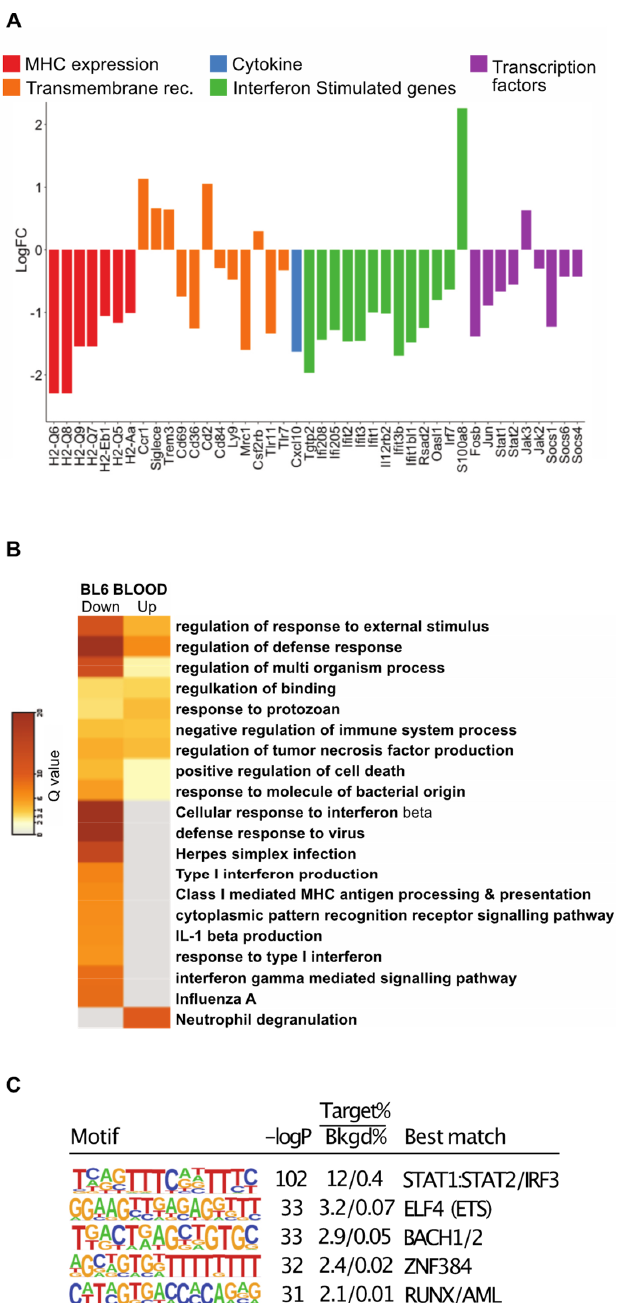
Figure 5. Analysis of DEGs for blood monocytes in C57BL/6 mice with late cancer. ( A ) Histogram of LogFC in selected DEGs for blood monocytes. Genes have been selected and grouped functionally as cytokines (blue), transmembrane receptors related to MHC expression (red), IFN response (orange), interferon stimulated genes (green), and transcription factors (purple). ( B ) Pathways for all DEGs in the data sets using Metascape. Each column represents up- or down-regulated gene sets. Log q.values are plotted, and each bar colored according to the log q.value on a scale of 0 to 30, represented with graduating intensity from cream to dark brown. Gene Ontology or KEGG terms are annotated. ( C ) Transcription factor motif enrichment analysis of the promoters of down-regulated DEGs revels STAT1/STAT2 as the most highly enriched.